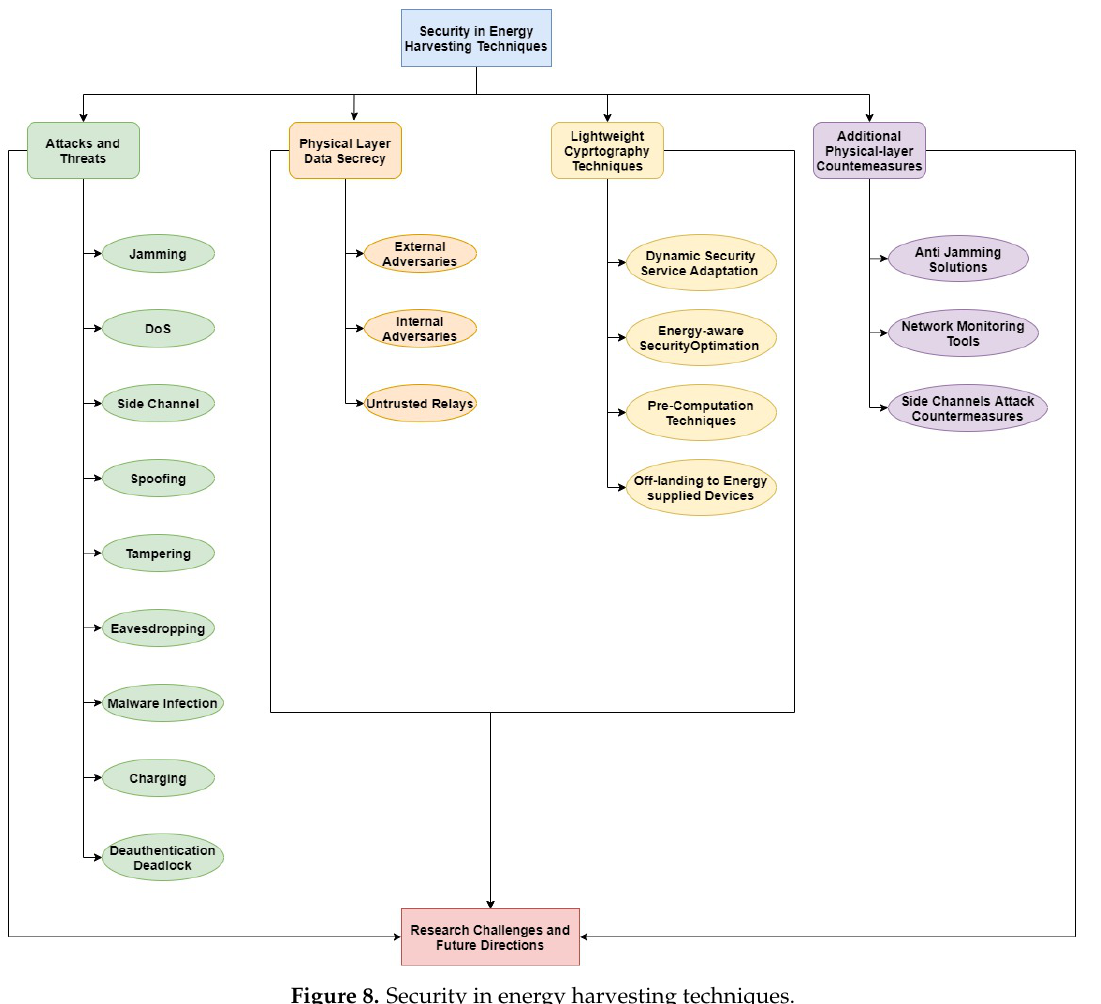
Figure 8. Security in energy harvesting